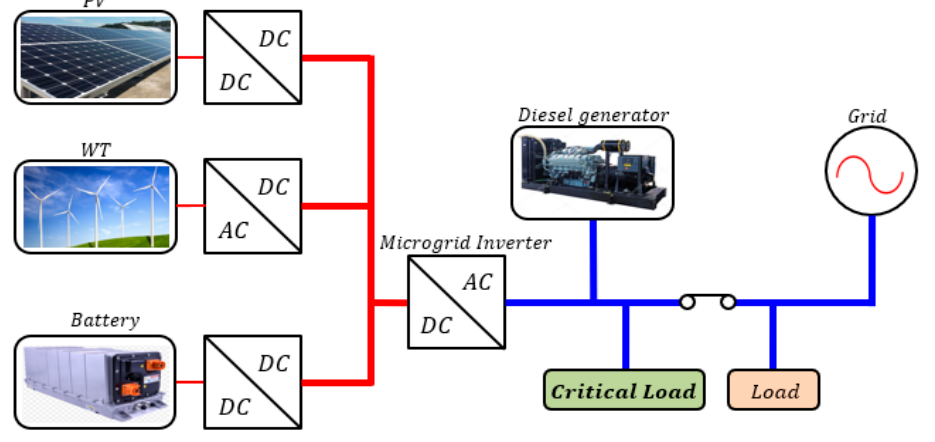
Figure 1. Block diagram of microgrid system.